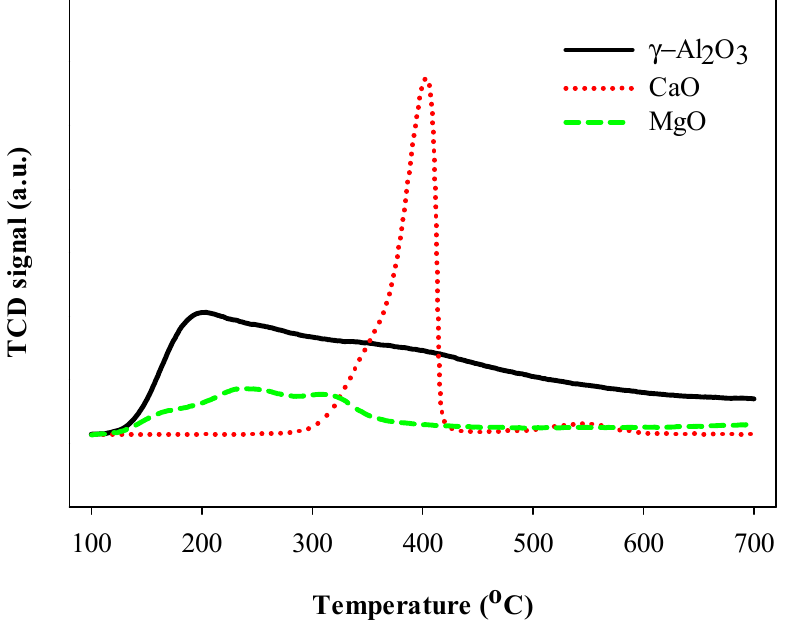
Figure 3. NH 3 -TPD curves of fresh catalysts used in this study. Table 1. The amount of weak, intermediate, strong, and total acid sites of fresh γ -Al 2 O 3 , MgO, and CaO.